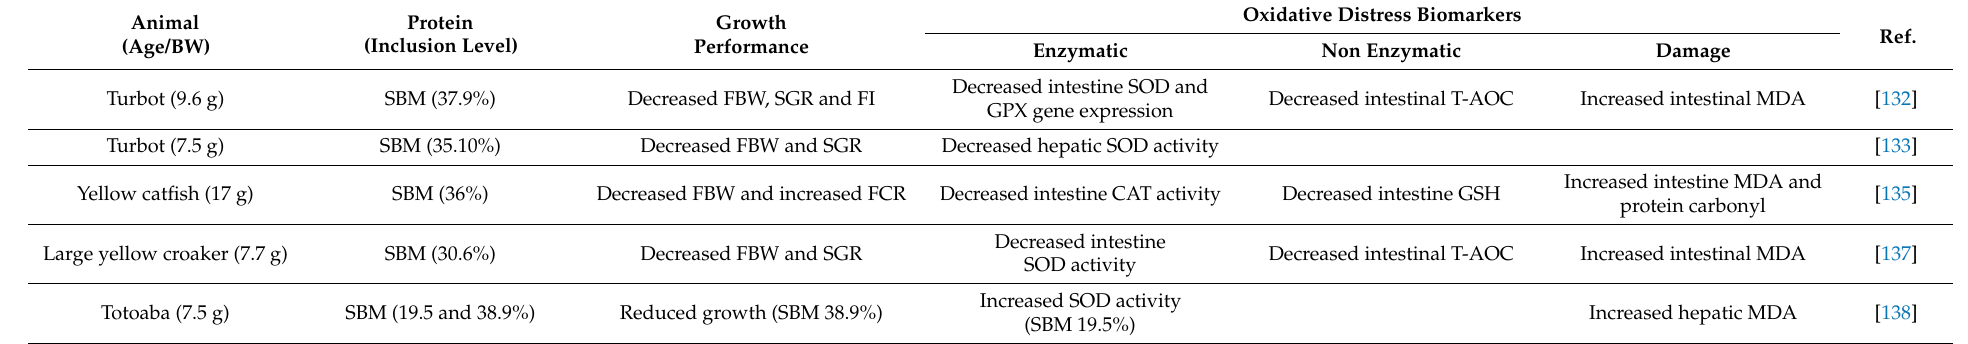
Table 5. Summary of the dietary oxidative challenges models using soybean meal in fish diets, including inclusion level and results, including effect on zootechnicalperformance and markers of oxidative distress classified as enzymatic, non-enzymatic, or